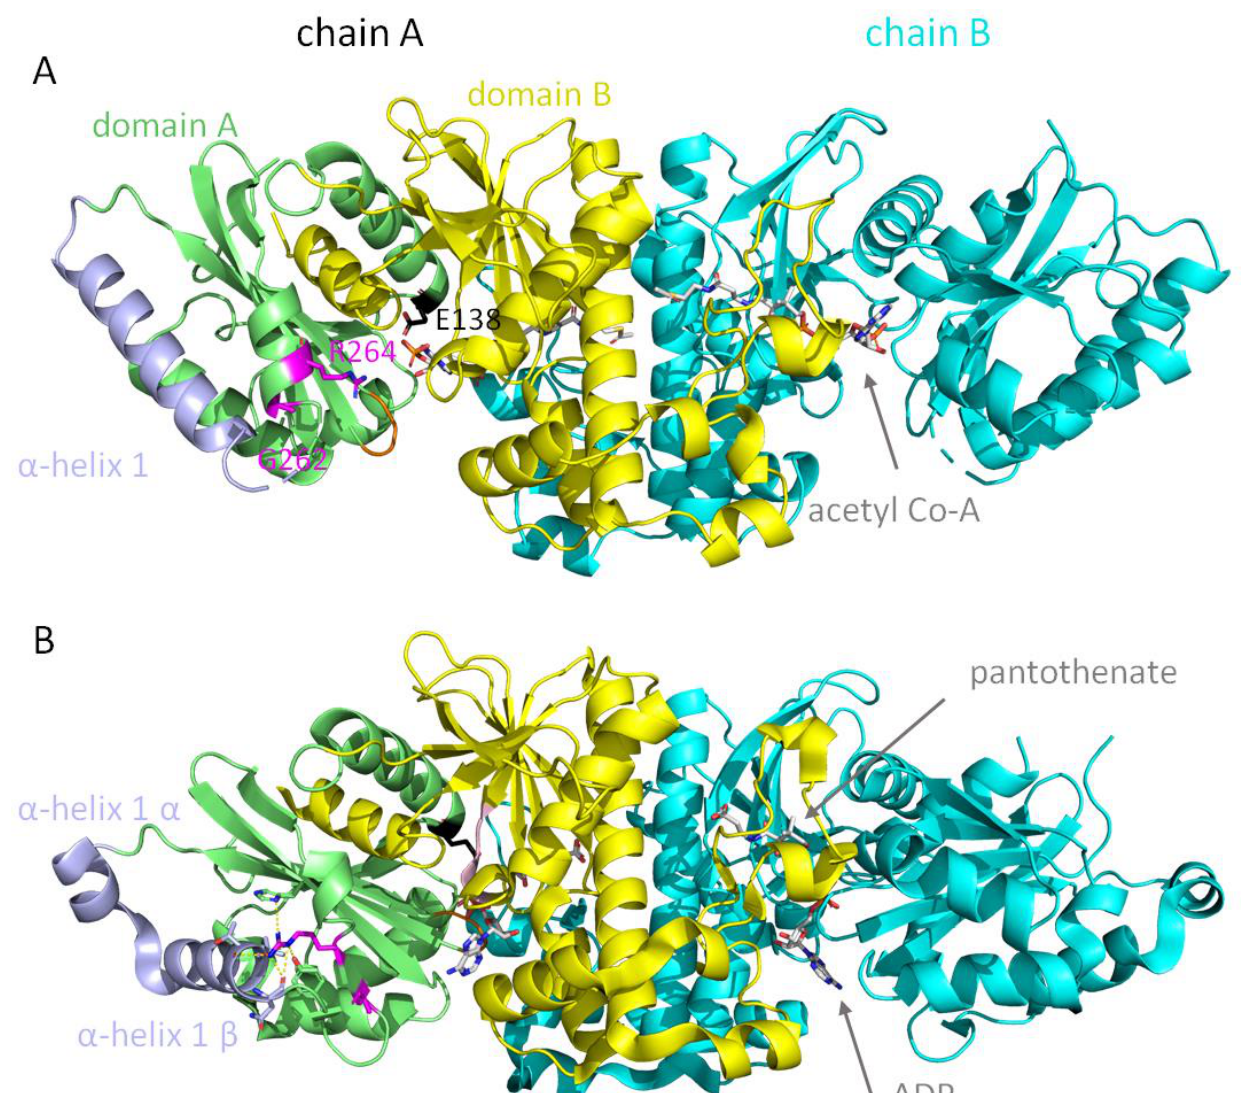
Figure 3. Conformational changes between inactive and active states of PANK and movement of G262 and R264. ( A ) PANK3 dimer structure (PDB 3mk6) (inactive conformation) is shown in cartoon representation. Domains A and B of the first subunit are shown in lime and yellow, respectively, and the chain B in cyan. Acetyl-CoA is shown as sticks. The glycine-rich ATP binding loop is highlighted in orange and the short ATP binding helix in light pink. Alpha-helix 1 is shown in light blue and G262 and R264 are shown in magenta as sticks. Catalytic residue E138 is shown as black sticks. ( B ) PANK2 dimer structure (PDB 5e26) (active conformation) is shown in cartoon representation. Upon release of acetyl-CoA a conformational switch happens in domain A. Alpha-helix 1 is broken into helix1 α and helix1 β . R264 is rotated 180 ◦ and makes many polar and ionic interactions with residues of domain A. ADP and pantothenate are shown as sticks. Yellow dashes indicate ionic and hydrogen bonding of R264 to several amino acids of domain A.